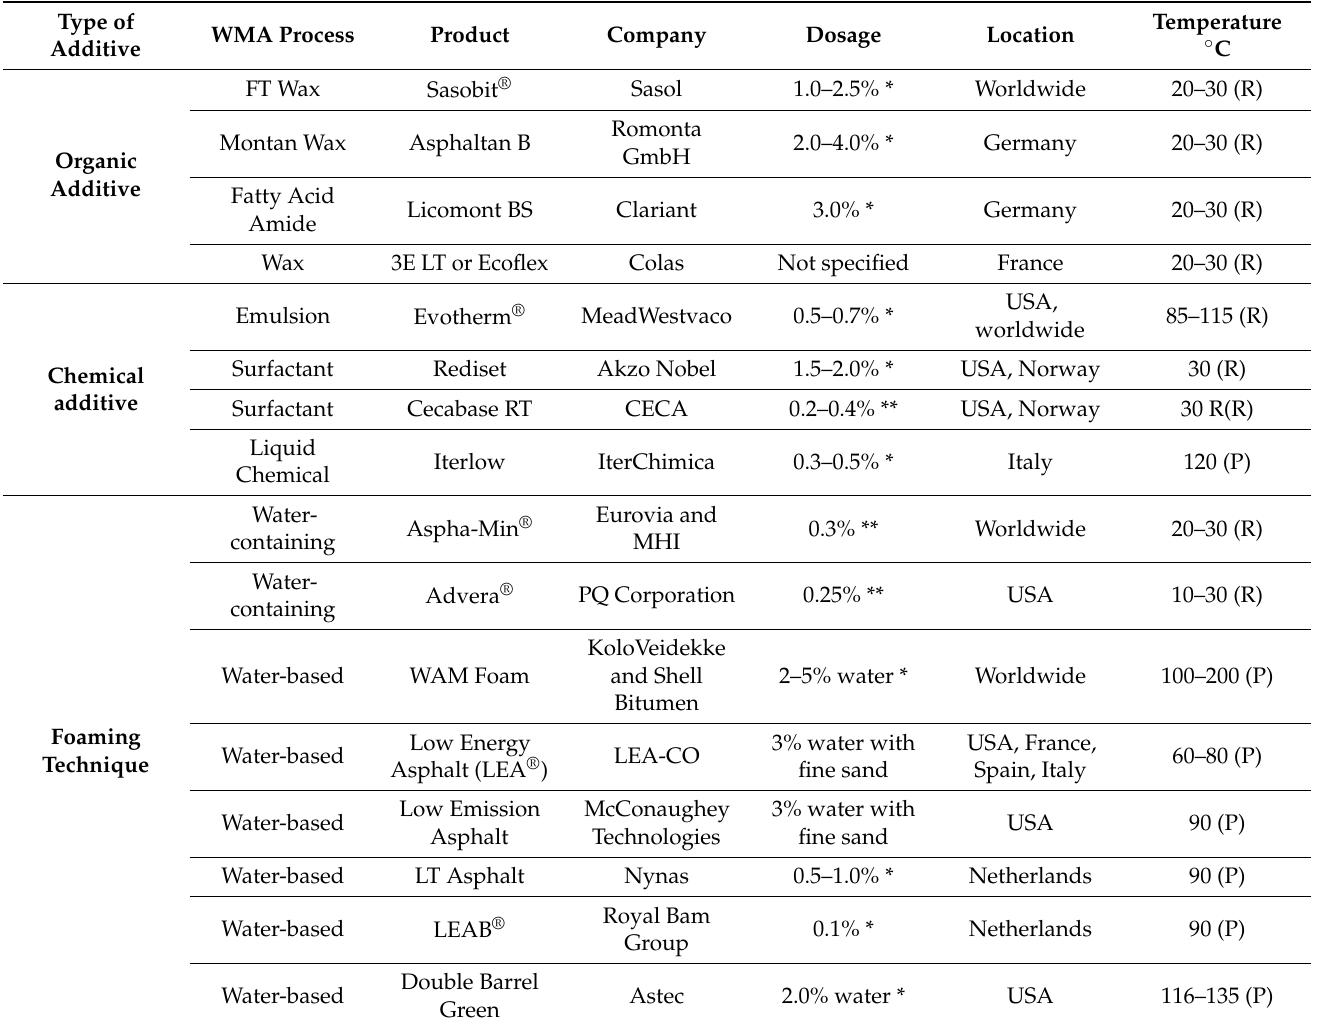
Table 3. Warm mix technologies and